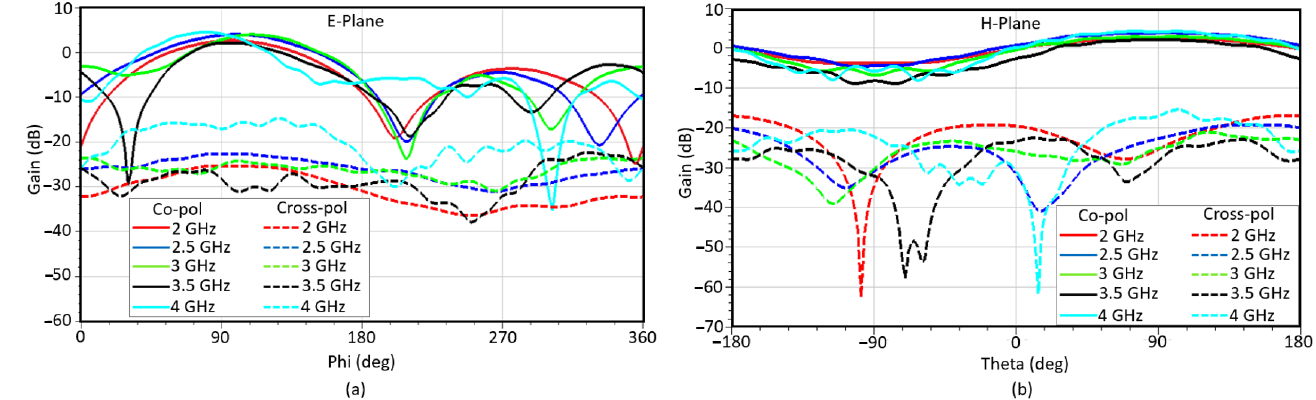
Figure 16. Co- and cross-polarized radiation patterns of the proposed antenna 2 in the ( a ) E (XY)- plane and ( b ) H (YZ)-plane. and ( b ) H